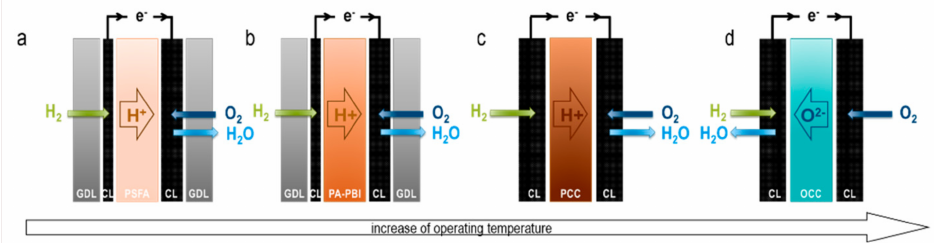
Figure 2. Schematic representation of the FC types considered herein in order of increasing operating temperature: ( a ) PEFC, ( b ) HT-PEFC, ( c ) PCFC, ( d )